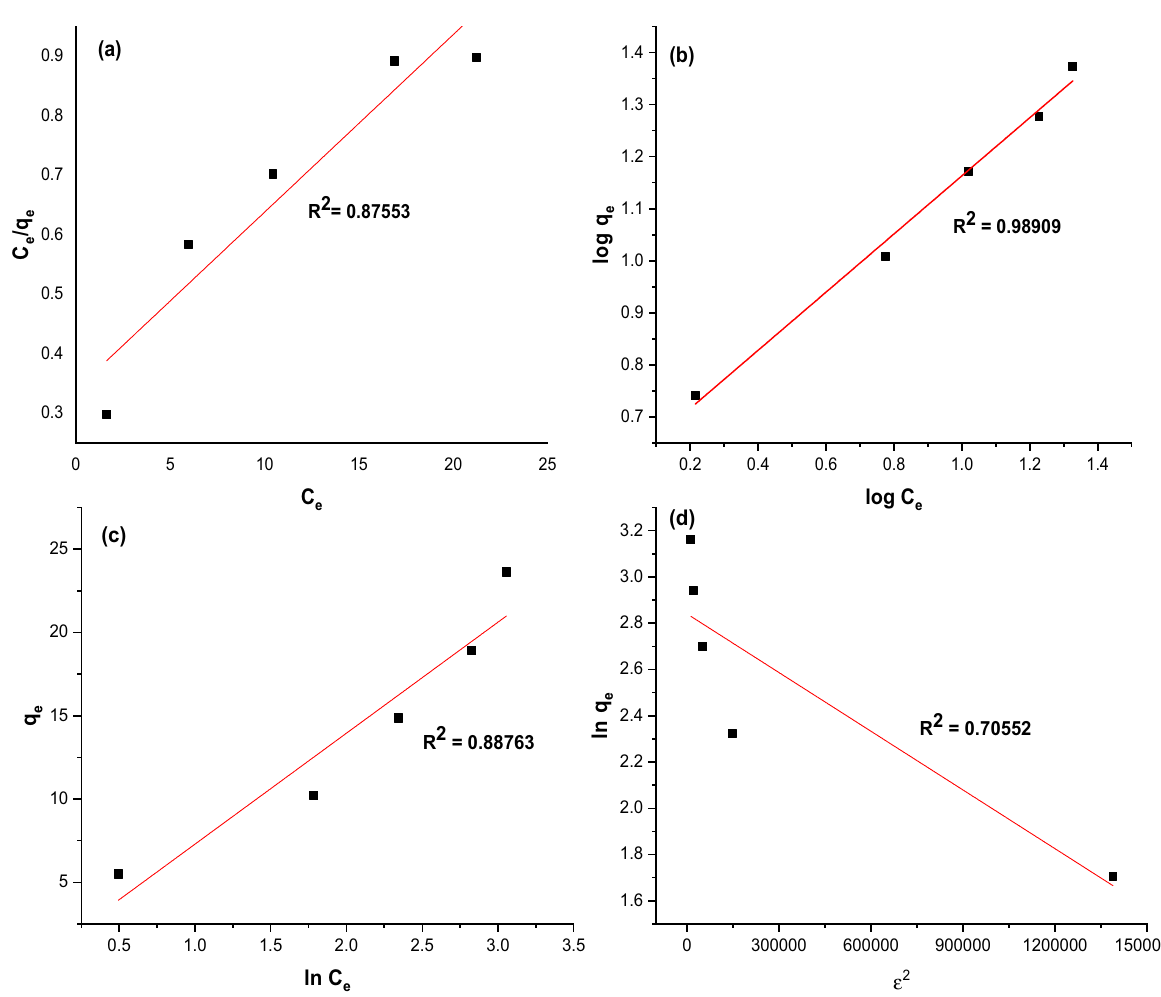
Figure 13. Plots of isotherm models for CR removal: ( a ) Langmuir, ( b ) Freundlich, ( c ) Temkin, and ( d )